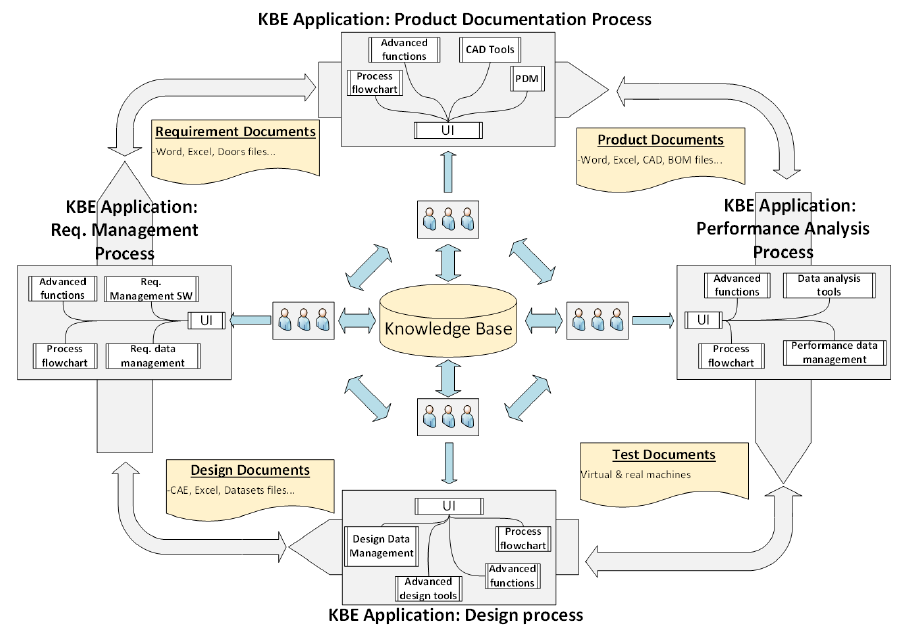
Figure 2. Knowledge-based engineering (KBE) system framework for the electric machine development process.